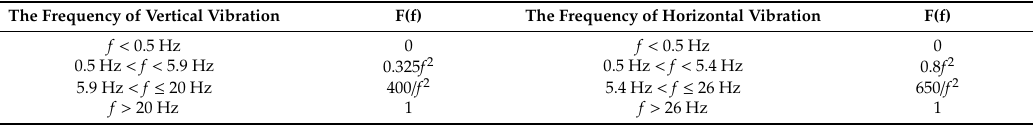
Table 6. The value of the frequency correction coe ffi cient F(f).